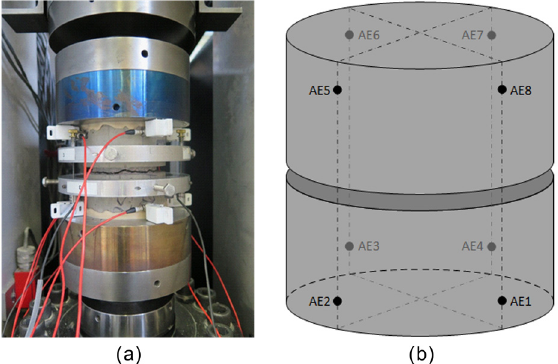
Figure 5. Uniaxial tensile test setup with AE sensors during cyclic testing (a) and schematic of AE sensor locations and numbering on the specimen (b).